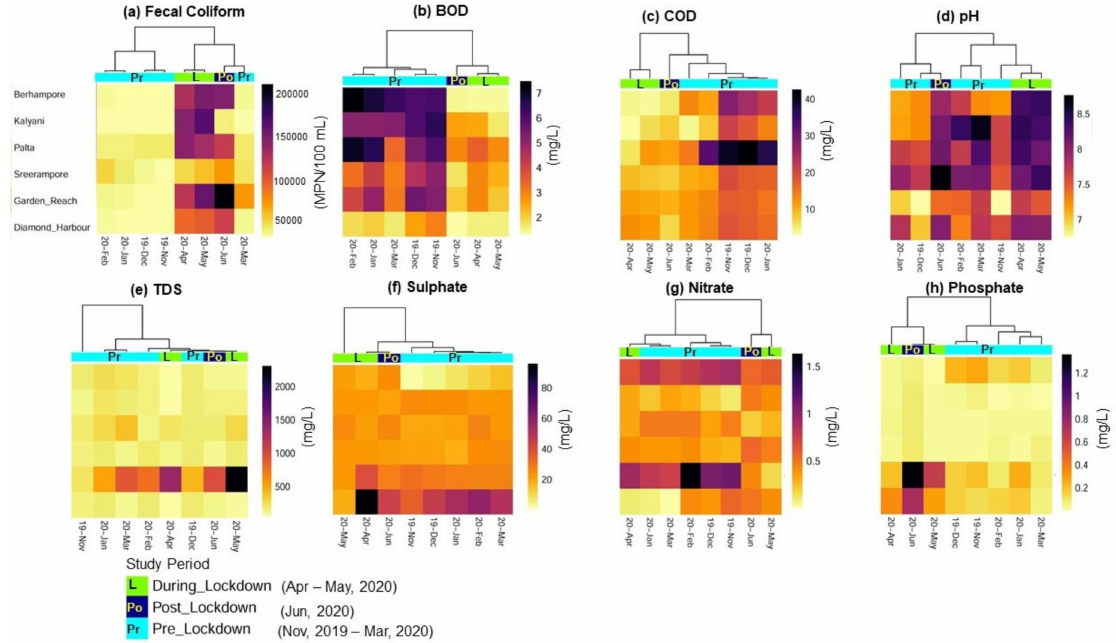
Figure 5. Heatmap of Pearson correlation based on average abundances of ( a ) FC (MPN/100 mL), ( b ) BOD (mg/L), ( c ) COD (mg/L), ( d ) pH, ( e ) TDS (mg/L), ( f ) sulfate (mg/L), ( g ) nitrate (mg/L) and ( h ) phosphate (mg/L) across the lower reaches of Ganges river from March to July